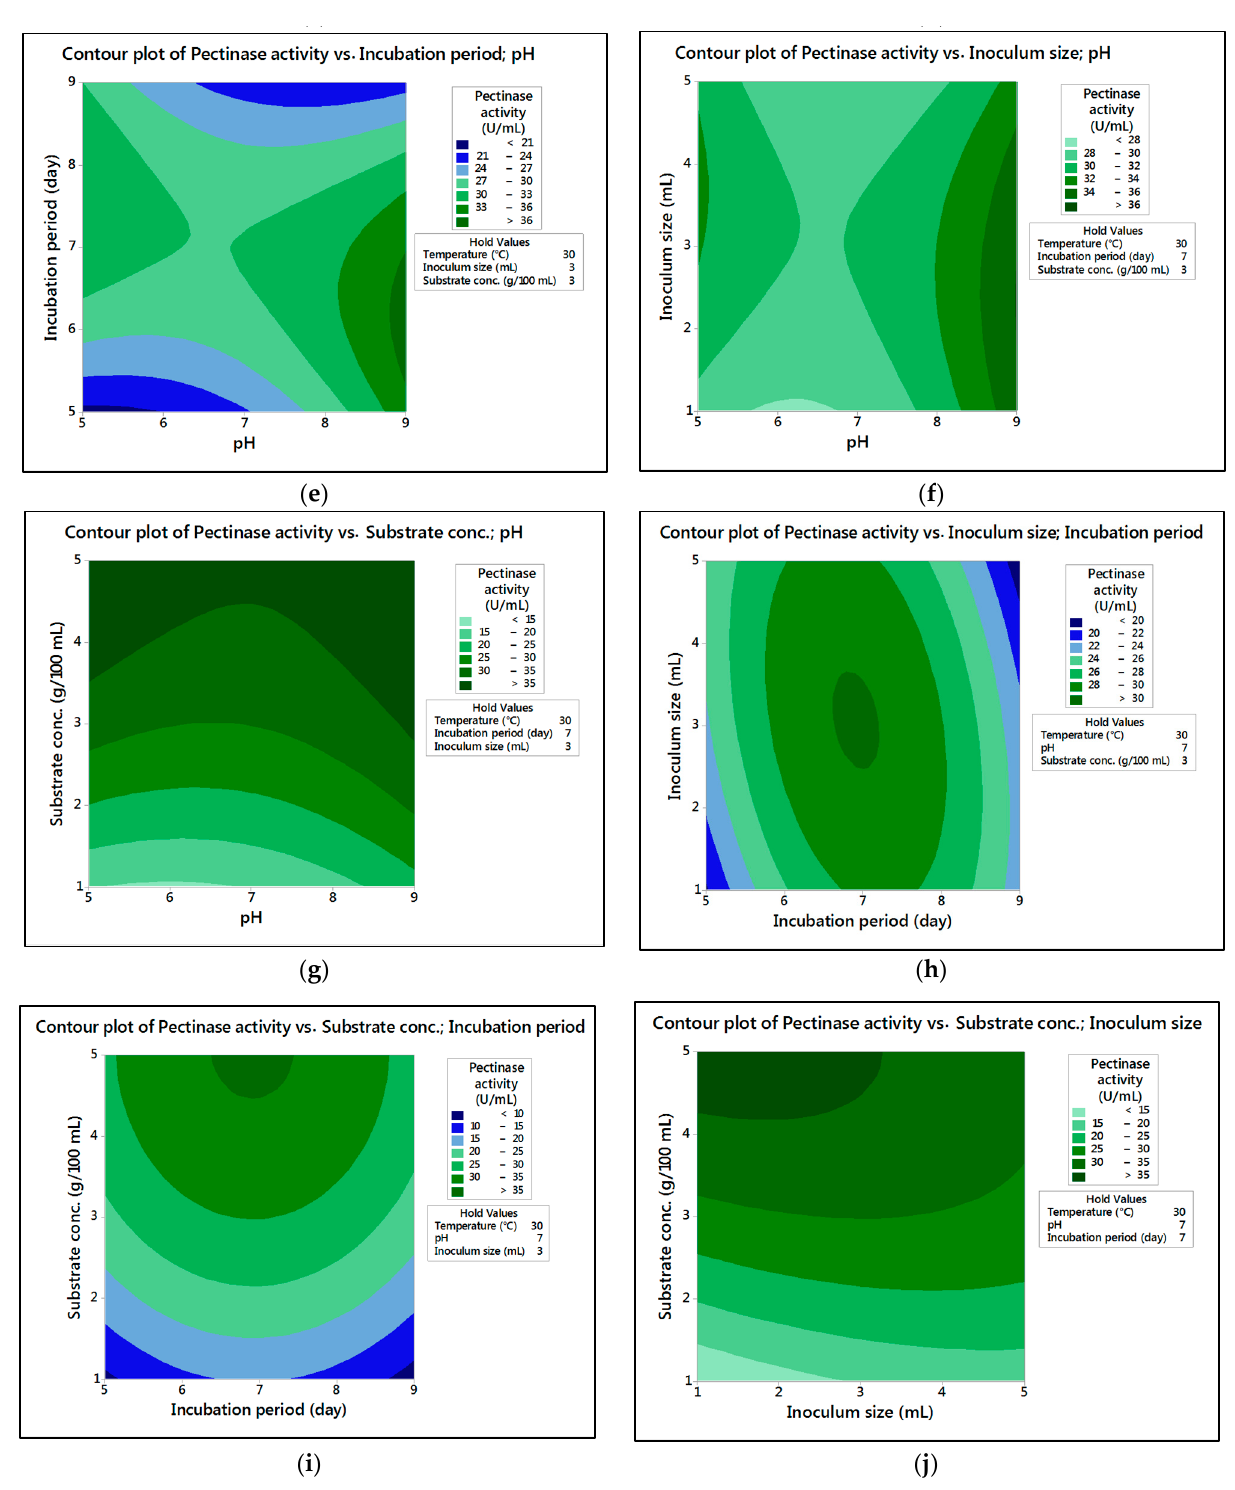
Figure 6. Contour plot showing interactions between independent variables: ( a ) incubation tem- perature with pH; ( b ) incubation temperature with incubation period; ( c ) incubation temperature with inoculum size; ( d ) incubation temperature with substrate concentration; ( e ) pH with incubation period; ( f ) pH with inoculum size; ( g ) pH with substrate concentration; ( h ) incubation period with inoculum size; ( i ) incubation period with substrate concentration; ( j ) inoculum size with substrate concentration for pectinase activity produced by M. hiemalis .